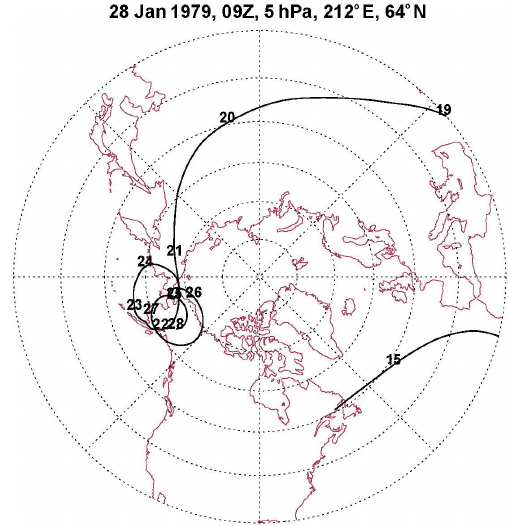
Figure 11. Trajectory of air parcel that ends on 28 January at the location of the LOP. Numbers on the trajectory denote the date, be- ginning with 15 January, and where the parcel is equatorward of 30 ◦ N on 16–18